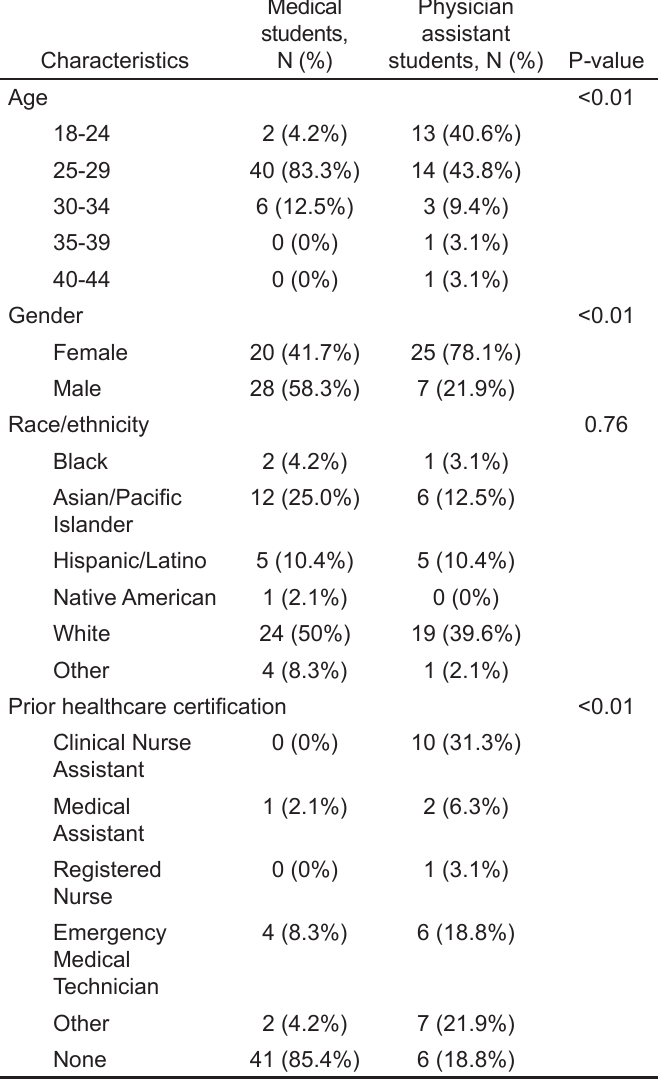
Table 1. Participant demographic